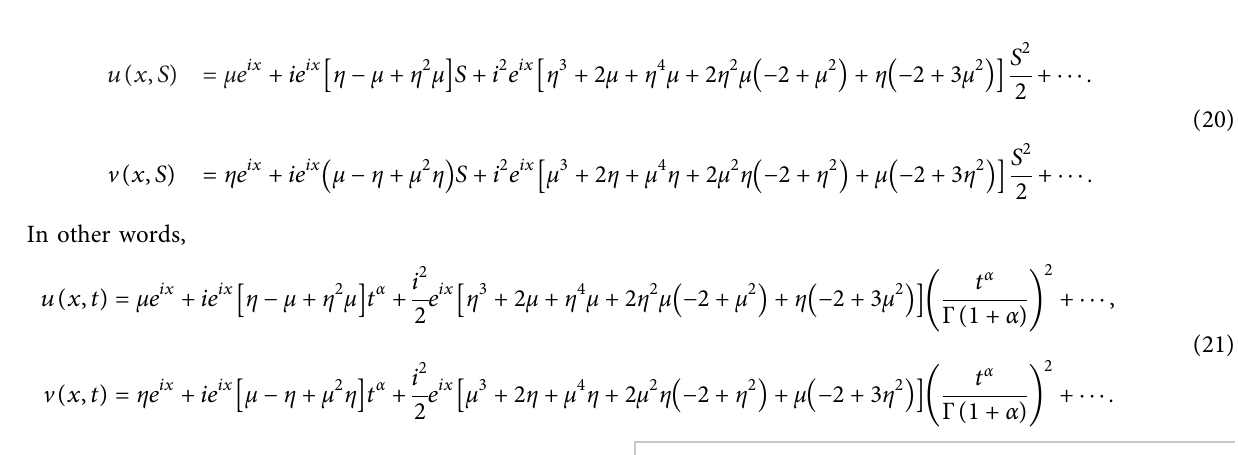
Figure 1: Surfaces plots for real part of u ( x,t ) for distinct values of α . (a) Numerical simulation of u ( x,t ) when α � 0 . 25. (b) Numerical simulation of u ( x,t ) when α � 0 . 50. (c) Numerical simulation of u ( x,t ) when α � 0 . 75. (d) Numerical simulation of u ( x,t ) when α �